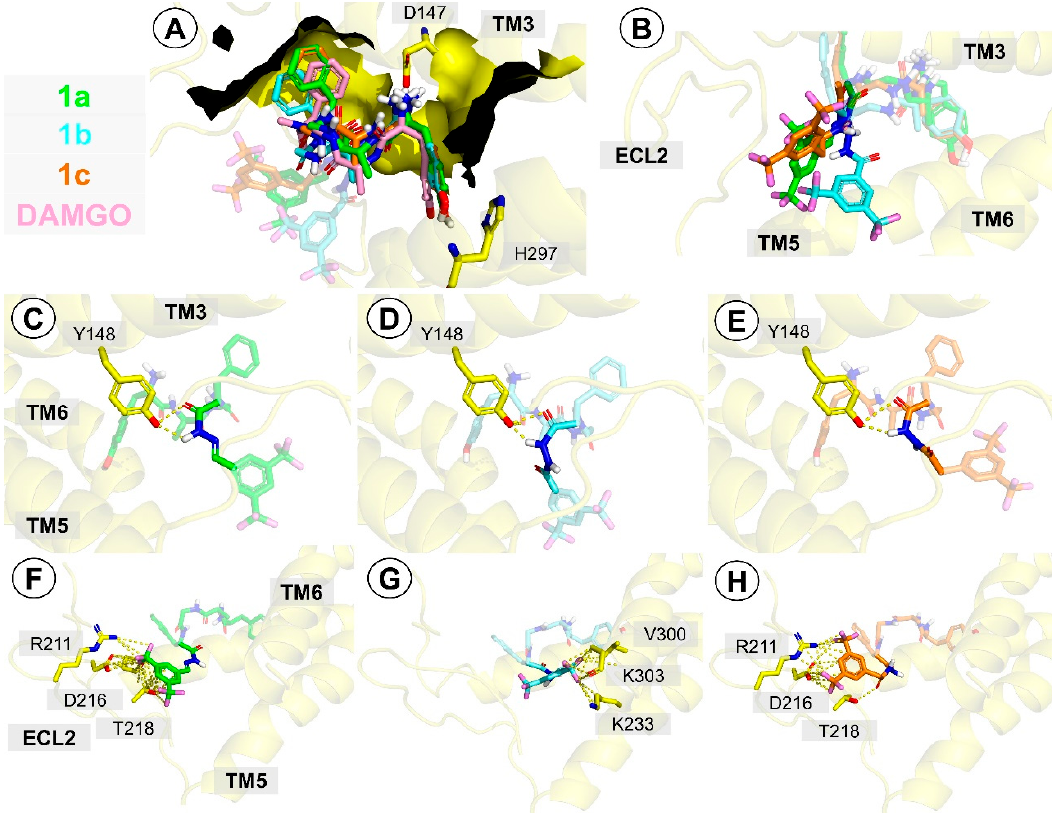
Figure 4. Binding modes of compounds 1a (green), 1b (aquamarine blue), and 1c (orange) in the MOR binding site (yellow). The ligands are shown as colored sticks. Several residues and transmembrane helices (relevant for each picture) are shown and labelled. Yellow dotted lines represent interactions. ( A ) All of the compounds superimposed on DAMGO (pink, from 6DDF [43]). ( B ) Focus on the C-terminal part and compounds 1a – 1c together. ( C – E ) Focus on the interactions with Y148 and compounds 1a ( C ), 1b ( D ), and 1c ( E ). ( F – H ) Focus on the C-terminal part and compounds 1a ( F ), 1b ( G ), and 1c ( H ).